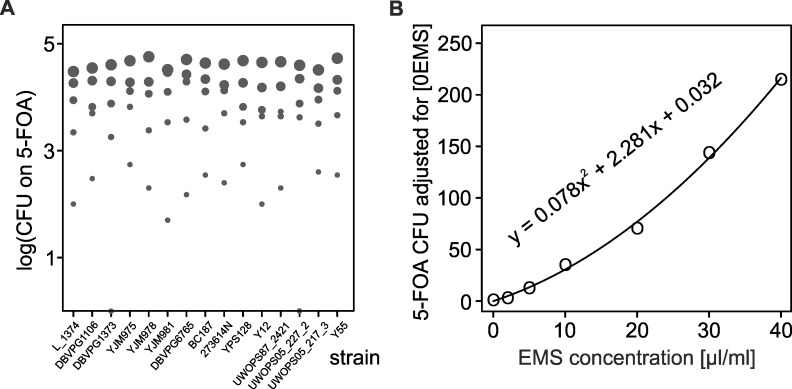
Relationship between EMS dosage and numbers of mutations introduced.(A) Number of URA3 mutations per strain per concentration estimated from c.f.u. counts on medium containing 5-FOA. The increasing sizes of dots represent increasing doses of mutagen, from 0 to 30 μl/ml. (B) The relation between the dose of EMS applied and the mutant count approximated by a polynomial function. The function is then used to replace the EMS dose by the “relative mutation load” measuring the increase in mutation number relative to untreated cells. (There are seven EMS doses at B and only five in A because for two doses, 2 and 40 μl/ml, there were lacking replicas and they were excluded from ANOVA testing for the strain and dose effects).